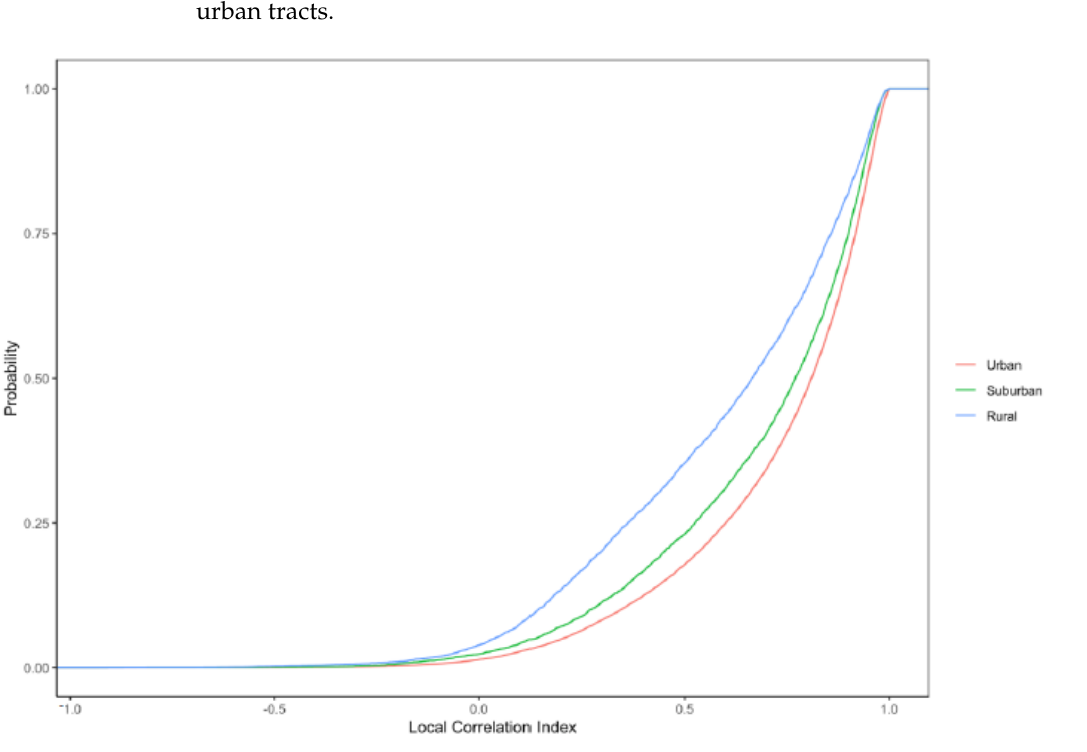
Figure 6. Cumulative distribution functions of the local correlation coefficient between RI and EI in urban, suburban, and rural census tracts.